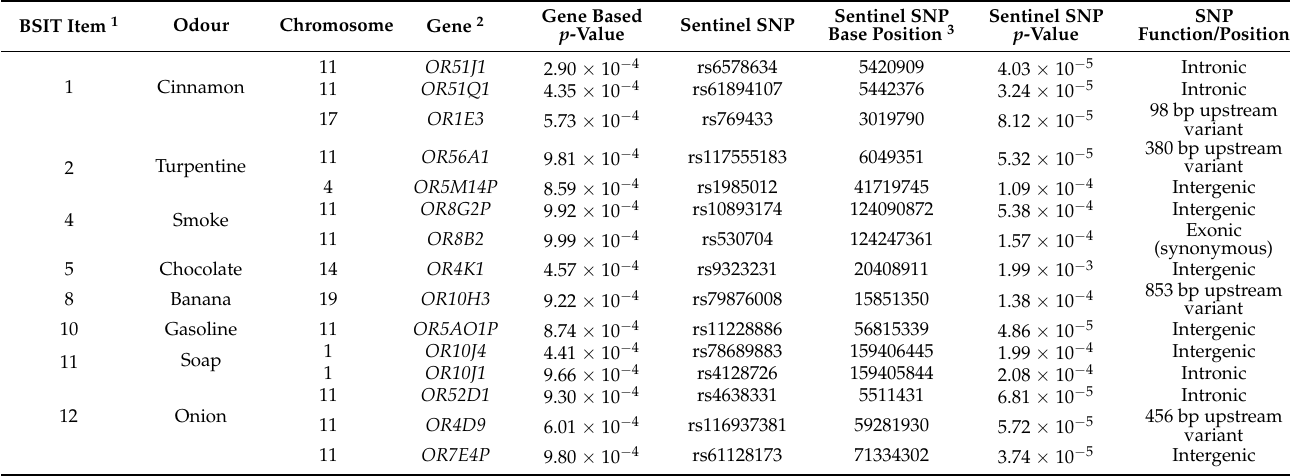
Table 3. Olfactory genes suggestively (p < 0.001) associated with individual odours from the BSIT and the sentinel SNPs from each gene ± 10